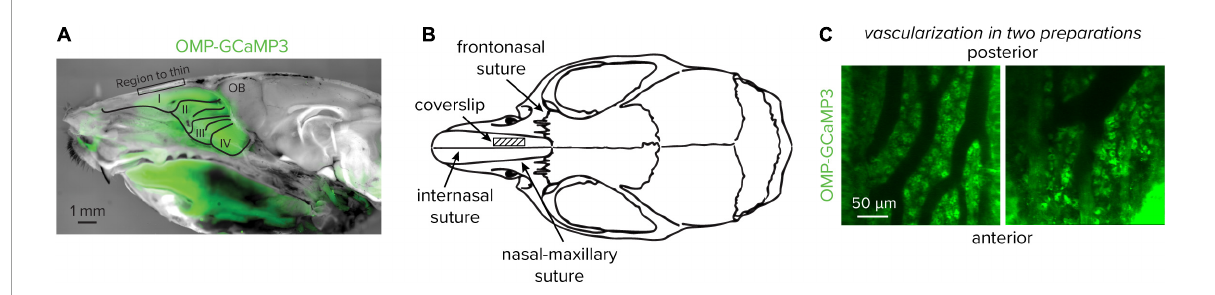
FIGURE2 Location of the thinned bone and coverslip placement. (A) A cross-section at the midline of an OMP-GCaMP3 mouse. Olfactory marker protein expression can be observed directly under the area to thin. (B) Location of the coverslip placement. The thinned bone and coverslip should be placed directly anterior to the frontonasal suture, between the internasal suture and nasal-maxillary suture. (C) Two-photon images of the dense vascularization of the olfactory epithelium and tight packing of sensory neurons from two separate